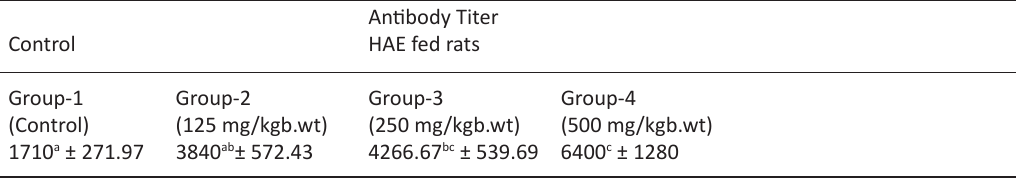
Table 2. Determination of Humoral response of Wistar albino rats fed with HME against S .typhimurium ‘O’ antigen Antibody